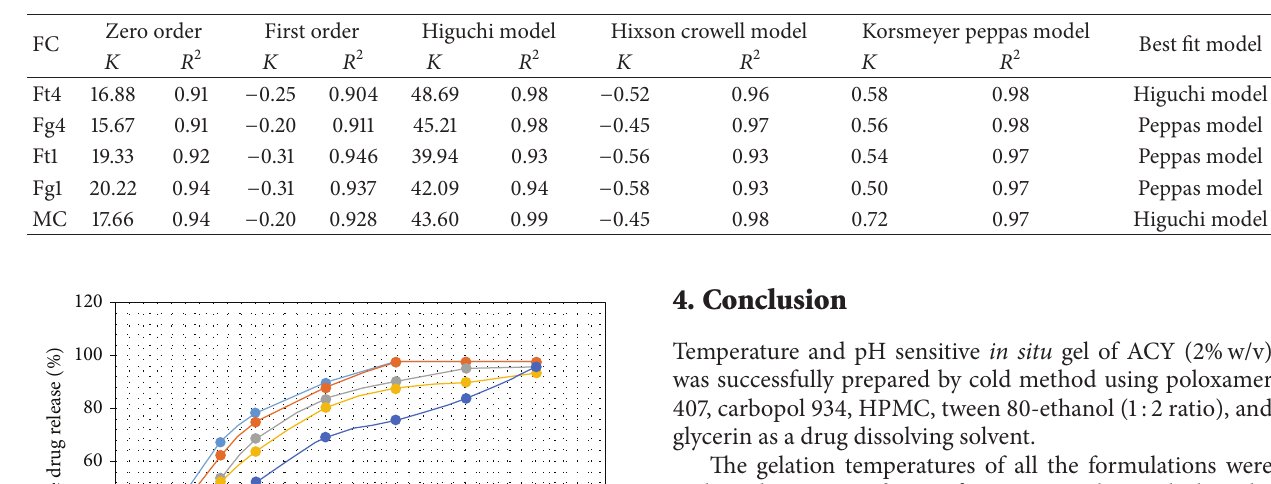
Table 7: Kinetic analysis of in vitro release data of different formulations.